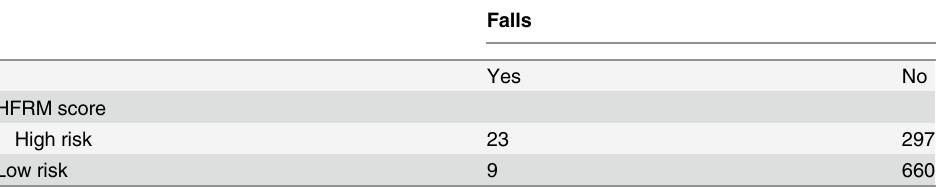
Table 2. Cross table of HFRM prediction of falls and actual falls during hospitalization.